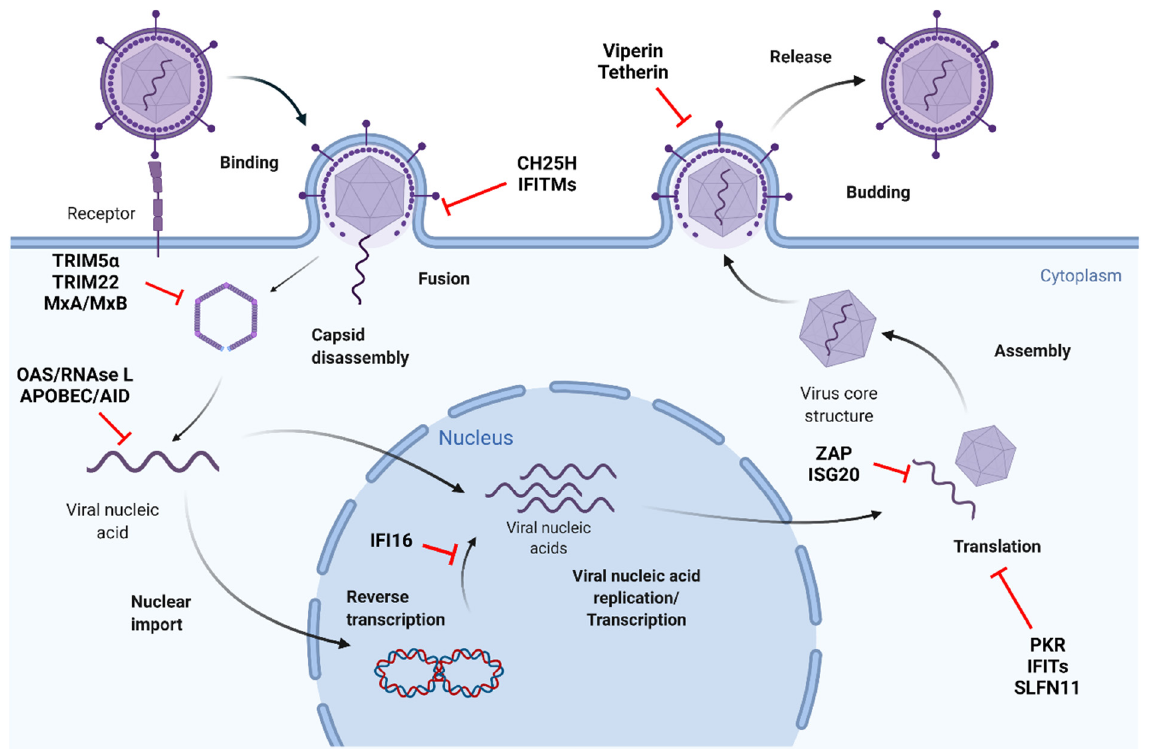
Figure 2. Restriction of viral life cycle by different ISGs for viruses with nuclear replication. ISGs with antiviral activity are shown for different steps of viral replication, including binding and viral entry, capsid disassembly, nuclear import, reverse transcription, viral nucleic acid replication/transcription, nuclear export, translation, capsid assembly, budding and release of viral particles. This picture was created in BioRender.